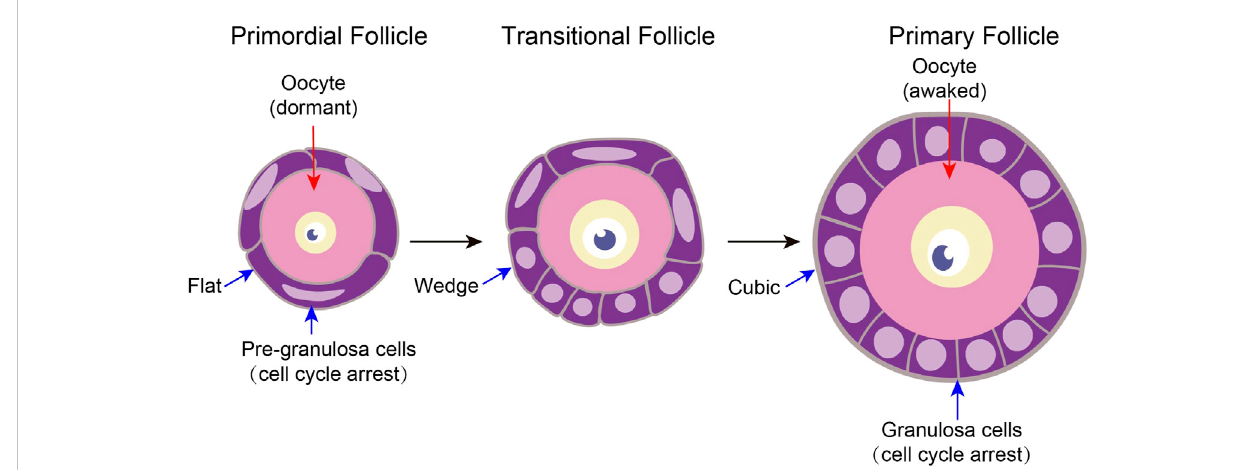
CharacteristicsoftissuestructurechangesinprimordialfollicleactivationAfollicleconsistsofasingleoocyteinthemiddleandseveralsomaticcells surrounding it. Primitive follicle activation mainly has two characteristics of structural changes. On the one hand, after primordial follicle activation, the pre-granulosa cells slowly changed from fl at to wedge-shaped, and then to cubic-shaped. On the other hand, the oocyte diameter